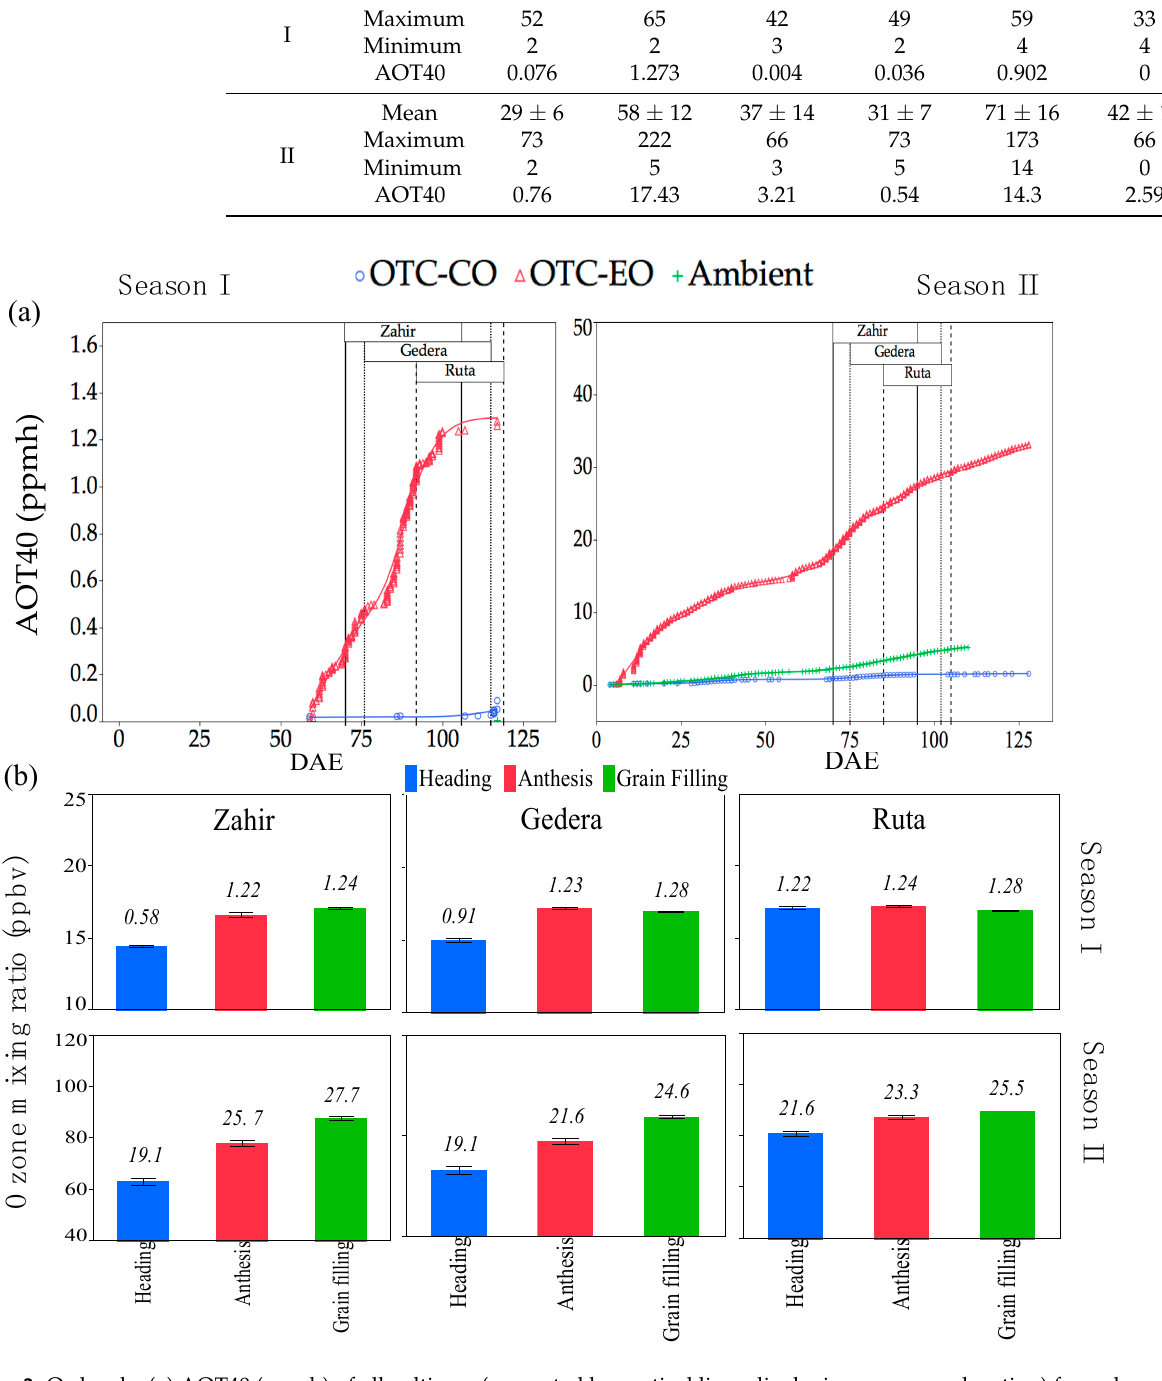
Figure 3. O 3 levels. ( a ) AOT40 (ppmh) of all cultivars (separated by vertical lines displaying exposure duration) from days after emergence (DAE) in O 3 -enriched OTC (OTC-EO), control OTC (OTC-CO), and ambient air during season I and season II. ( b ) O 3 mixing ratios at phenological stages of each cultivar. Values above bars are AOT40 (ppmh) from emergence until the end of each phenological stage (heading, anthesis, and grain filling), individually for season I and season II.